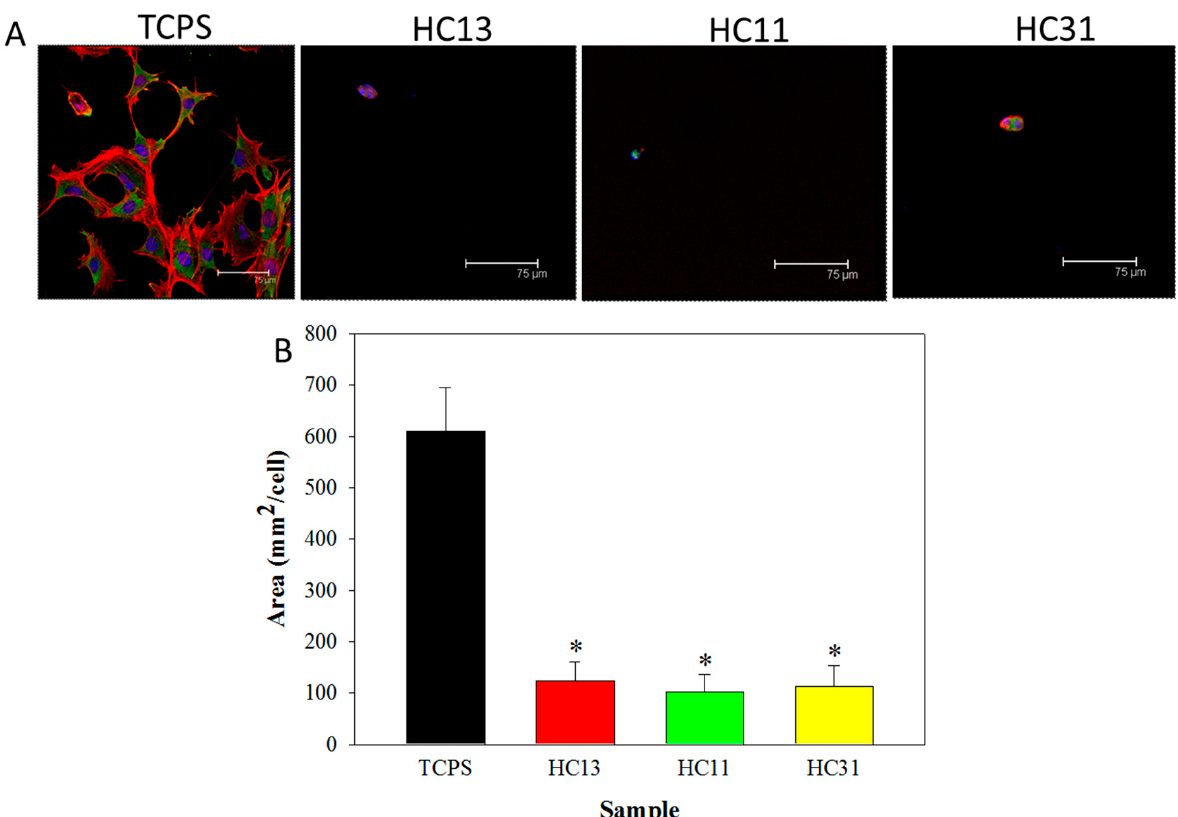
Figure 6. ( A ) The immunofluorescence (IF) staining image of vinculin (green), cytoskeleton (red) and nucleus (blue) after culture 3T3 fibroblasts on tissue culture polystyrene (TCPS) or HA/CMC hydrogel prepared at 1/3 (HC13), 1/1 (HC11) and 3/1 (HC31) mass ratios of HAMA/CMCMA. Bar = 75 μ m. ( B ) The quantification of the vinculin expressing area from 5 high power field regions in the IF images. * p < 0.05 compared with TCPS.